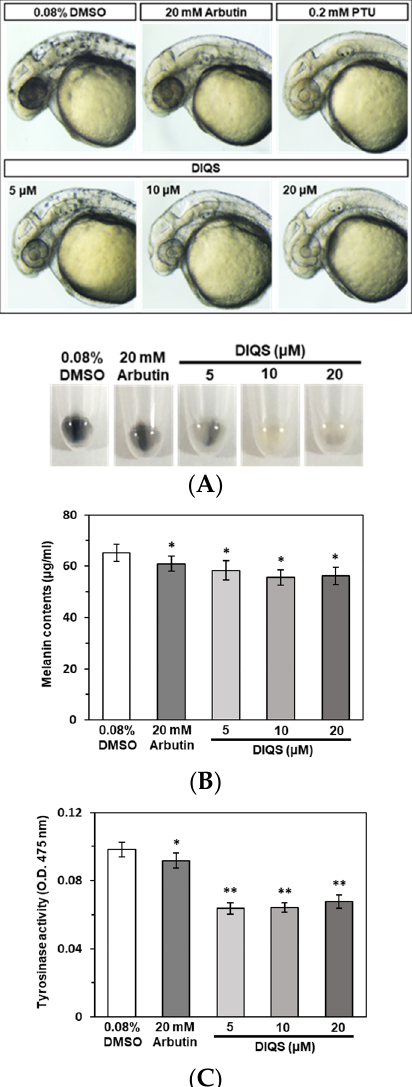
Figure 4. DIQS treatment inhibited melanogenesis in zebrafish embryos. Synchronized embryos were treated with 0.08% dimethyl sulfoxide (DMSO), 0.2 mM PTU, 20 mM arbutin, and various concentrations of DIQS. ( A ) Zebrafish embryos were photographed using the Leica MZ10 F stere- omicroscope and edited using the Leica Application Suite software. Lysates from zebrafish embryos were prepared as described in the Materials and Methods. Photographs were taken prior to meas- urement of the melanin content. ( B ) Melanin content in zebrafish embryos was dose-dependently inhibited by DIQS treatment. ( C ) For tyrosinase activity measurements, 2500 μ g total protein was incubated with 100 μ L of 1 mM L-DOPA for 1 h at 37 °C, and the absorbance was measured at 495 mm. Data are means ± SD. * p < 0.05 and ** p < 0.01 (vs. the DMSO-treated group).